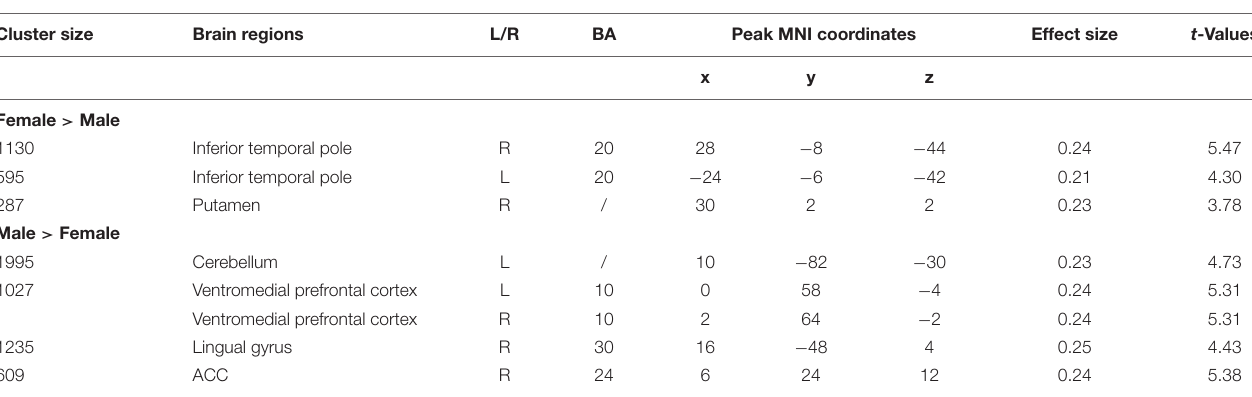
TABLE 5 | Results of seed-based correlation analysis using SMA as seed